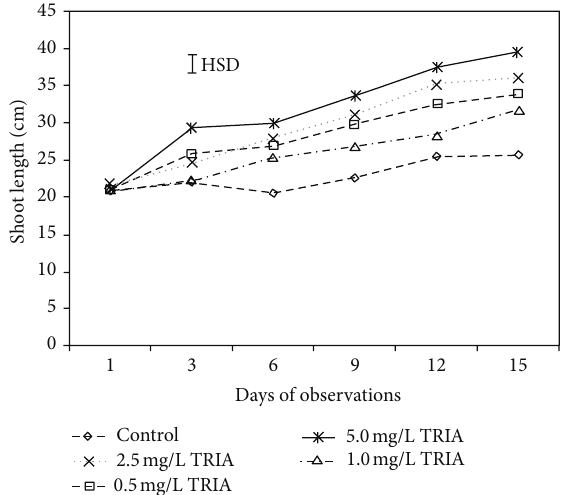
Figure 2: The effect of TRIA treatments on blooming rate of Bougainvillea glabra under natural conditions.